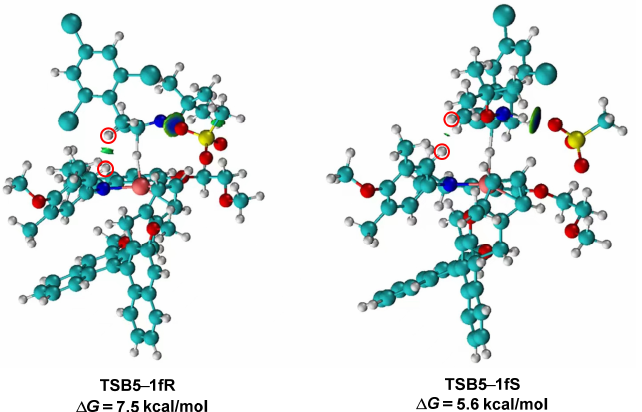
Figure 3. The IGMH analysis of the transition states of the MsO − -assisted hydride transfer step of the reaction by catalyst B1 ( δ g inter = 0.008 a.u.).